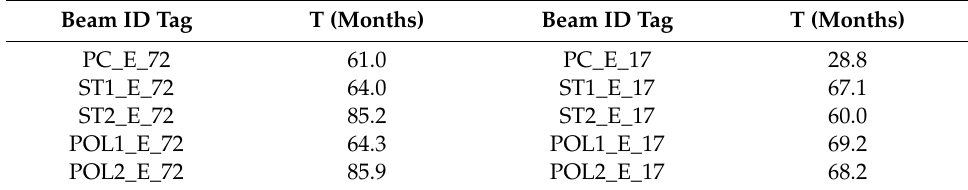
Table 6. Estimated time for the start of corrosion in exposed beams (17 and 72